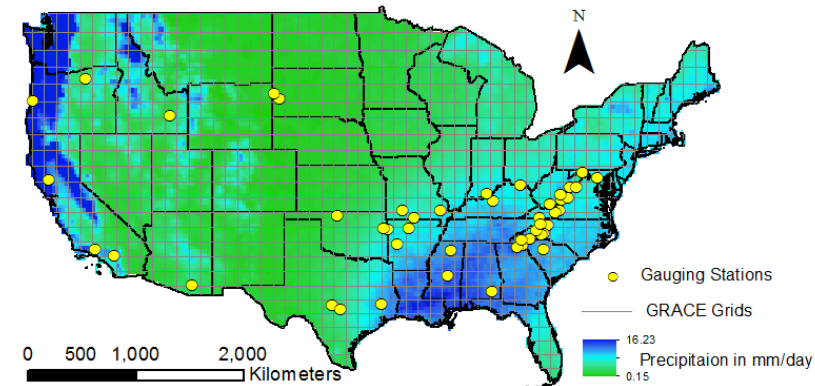
Figure 1. Locations of gauging stations of the study basins with yellow circles and GRACE (Gravity Recovery and Climate Experiment) data grids (gridlines in grey color) over the precipitation map of USA.